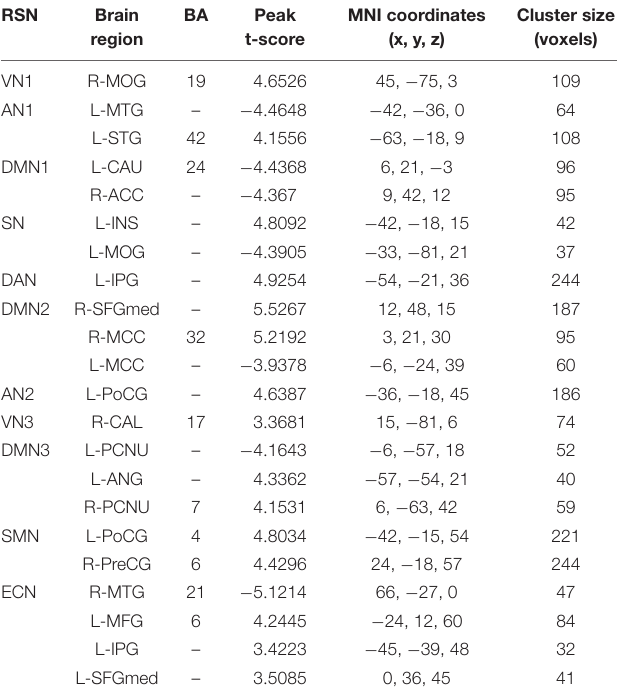
TABLE 2 | Intranetwork FCs of RSNs in the HM group.